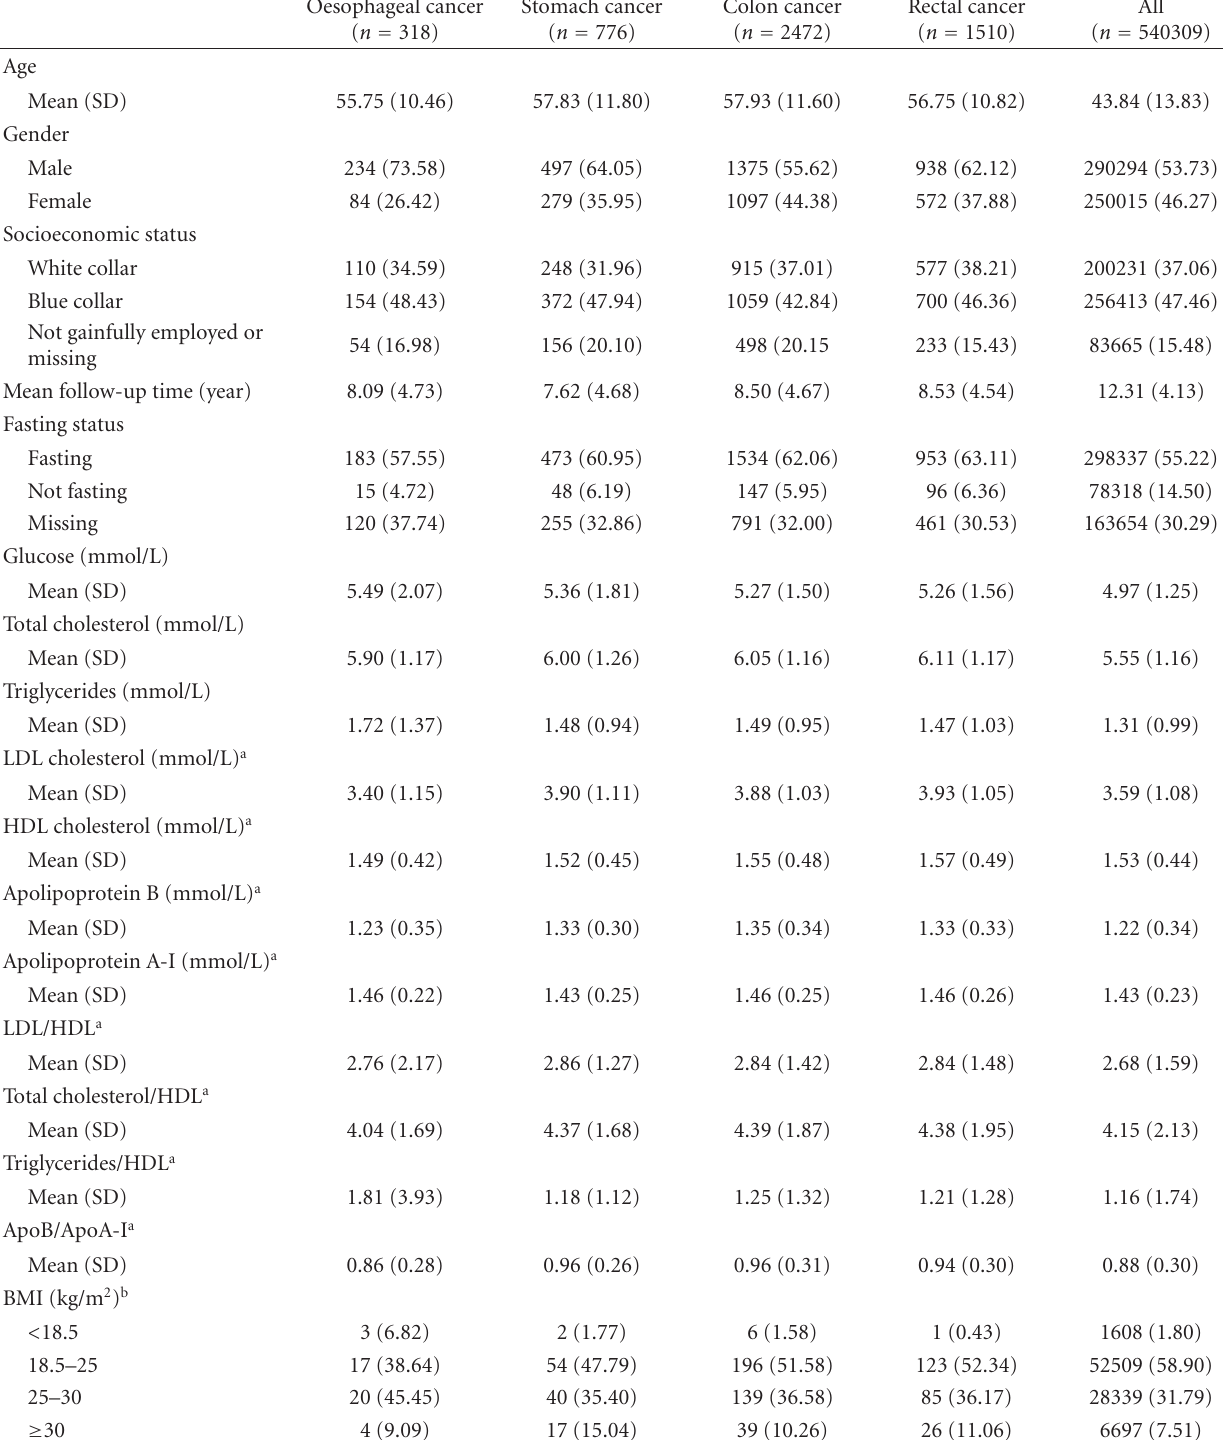
Table 1: Baseline characteristics of study